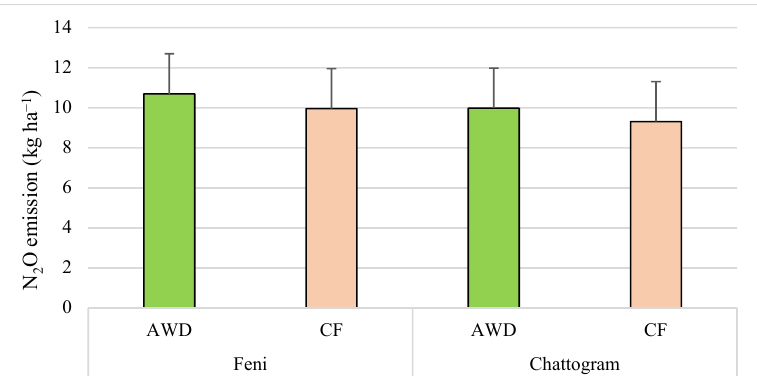
Figure 5. Effect of AWD and CF irrigation methods on the N 2 O emission from the paddy field in the Feni and Chattogram districts.